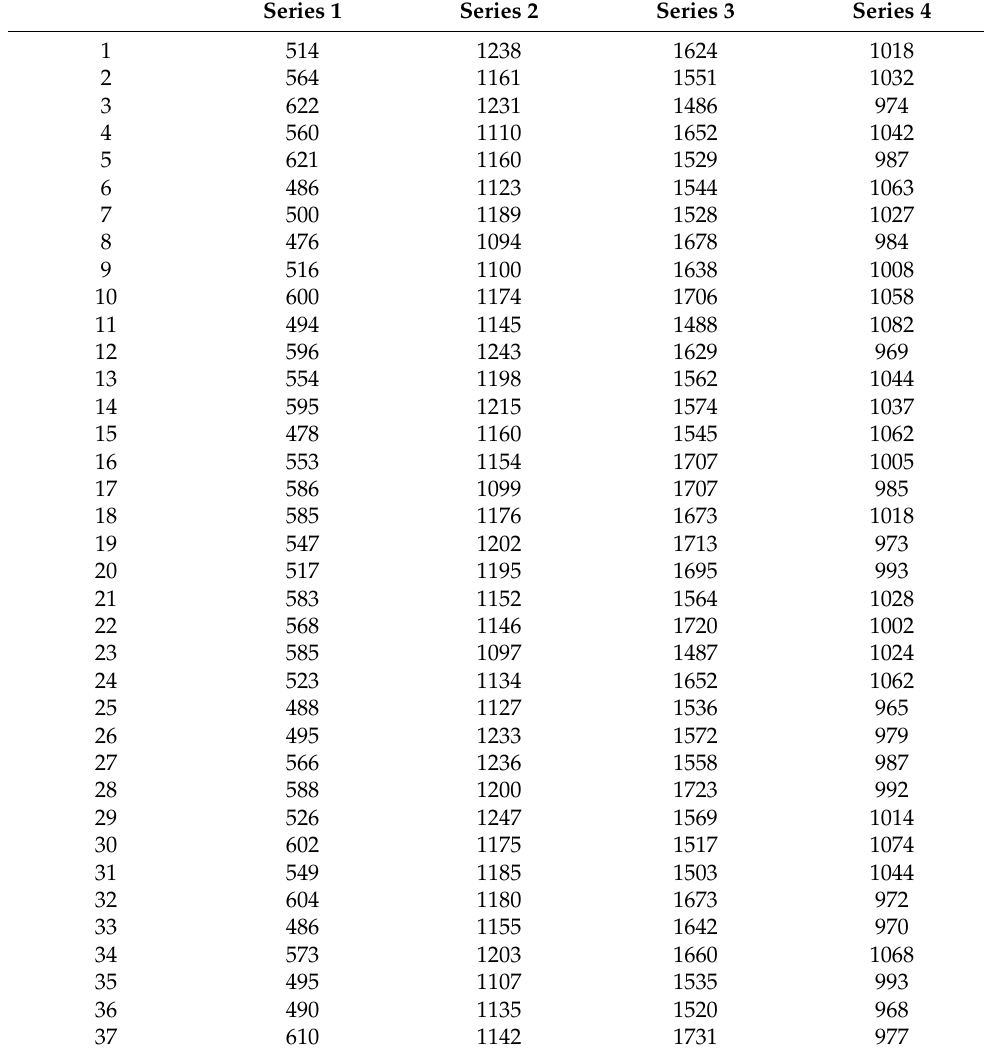
Table A4. Strength test results—shear force value